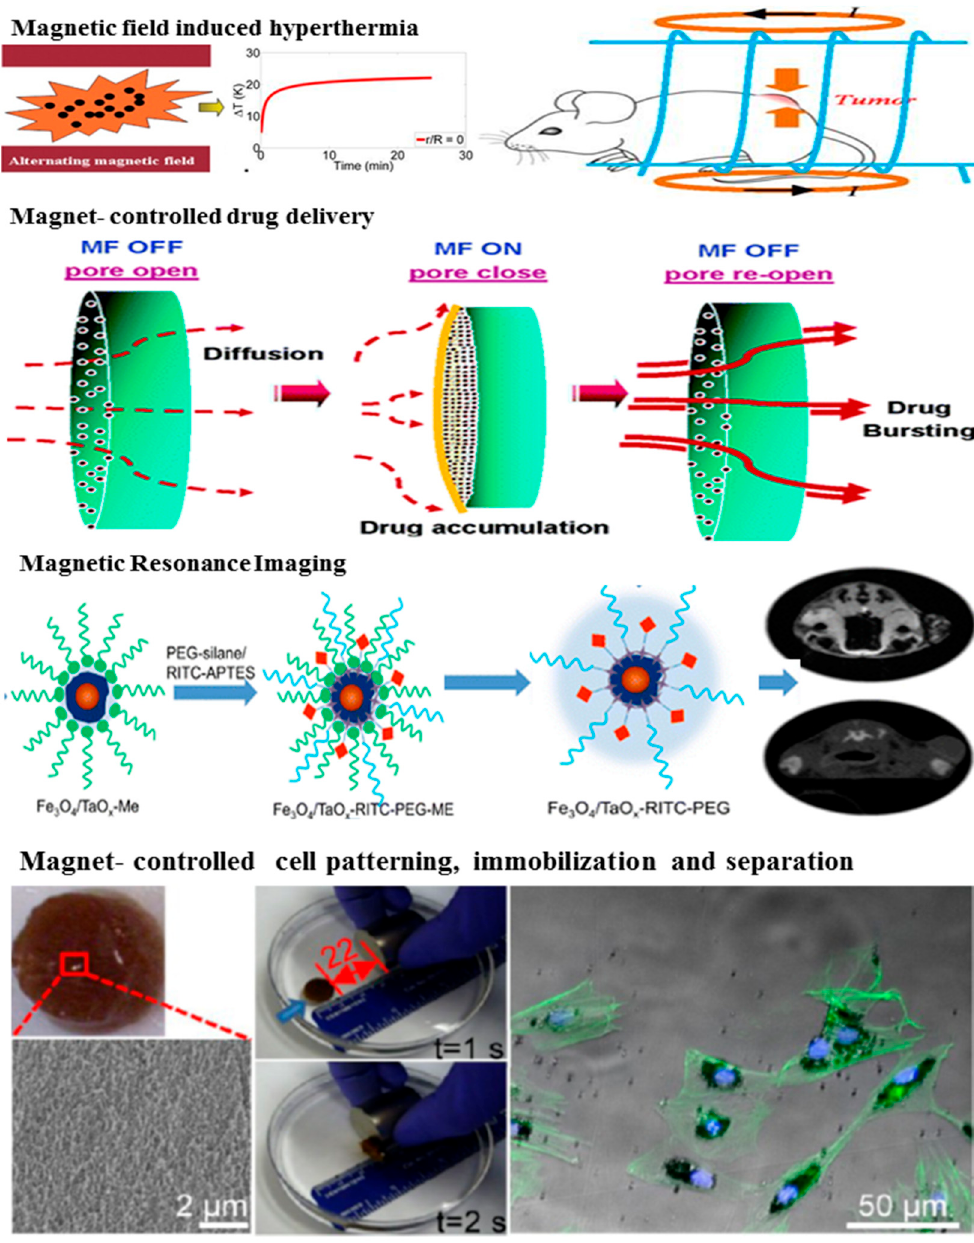
Figure 10. Schematic illustrations of typical biomedical applications of iron oxide NPs-hydrogel composites. Magnetic field induced hyperthermia, reproduced with permission from [286] Copyright Ivyspring International Publisher, 2012; Magnet-controlled drug delivery, reproduced with permission from [283]. Copyright American Chemical Society, 2006; Magnetic resonance imaging, reproduced with permission from [287]. Copyright American Chemical Society, 2012; Magnet-controlled cell patterning, immobilization and separation, reproduced with permission from [288]. Copyright American Chemical Society,